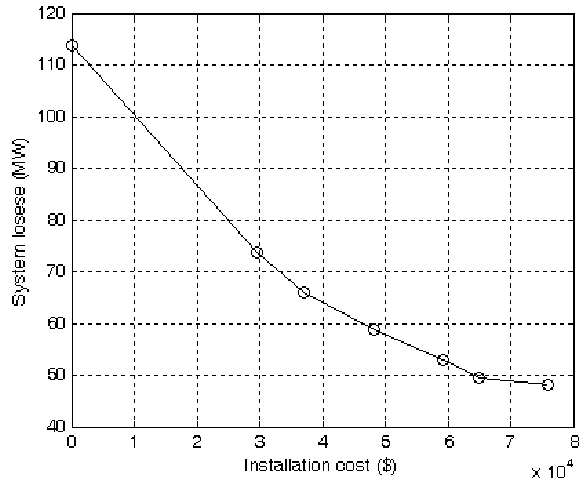
Figure 6. Relationship between the system losses and installation costs of various budget examples of investment on the IEEE 118-bus system.